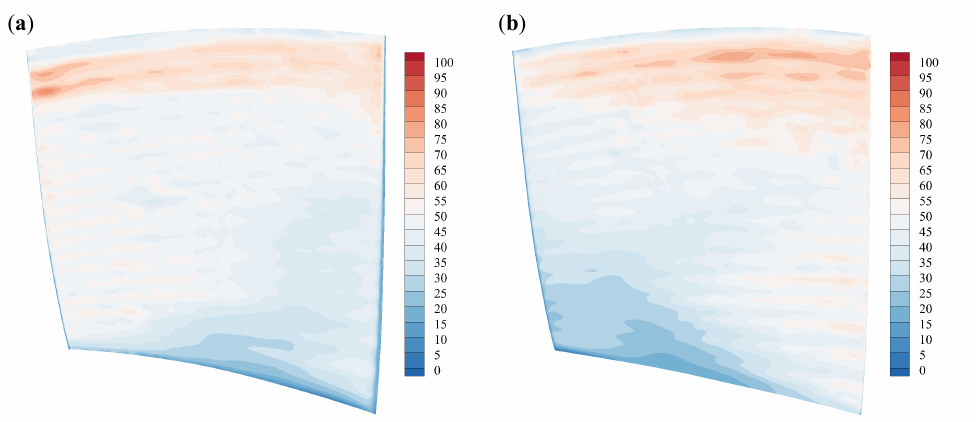
Figure 7. Unsteady pressure obtained by using different numbers of refinement level.